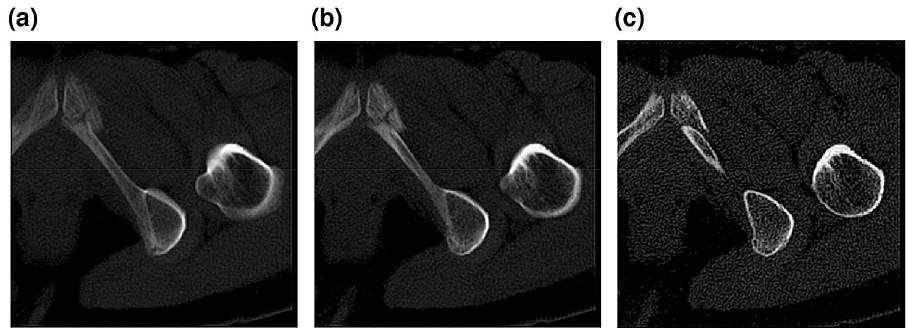
Figure 7. A 2.5D representation. ( a ) Image with 31-image thickness. ( b ) Image with 15-image thickness. ( c ) Image with 1-image